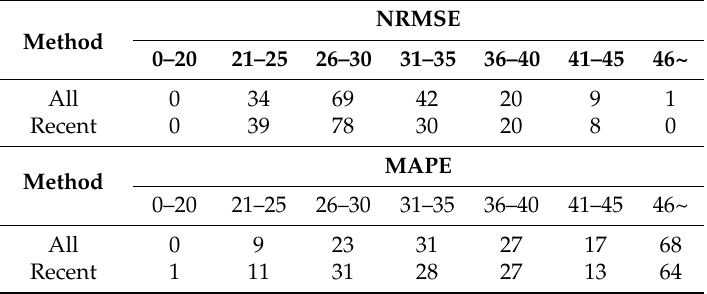
Table 4. The distributions of estimation errors of stations with and without recent data selection. ‘All’ represents the case without recent data selection and ‘Recent’ represents the case with recent data selection.